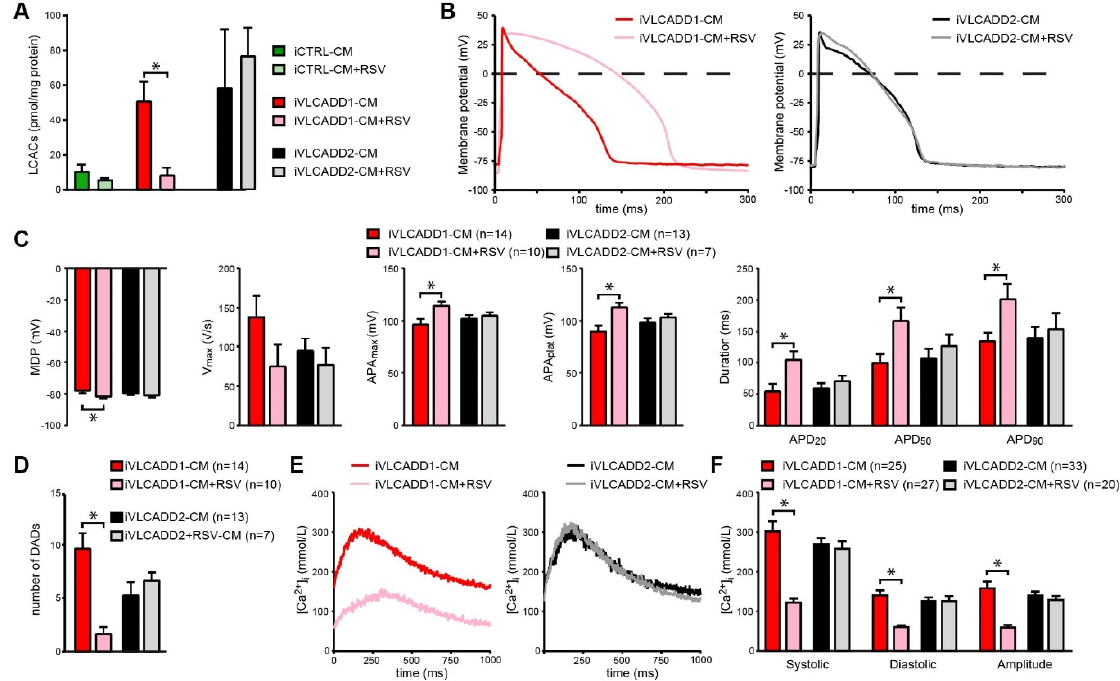
Figure 2. Rescue of electrophysiological abnormalities in iVLCADD1-CMs after pre-incubation with Resveratrol (RSV; 50 µmol/L). A . Intracellular acylcarnitine levels in iVLCADD1-CMs, iVLCADD2-CMs and iCTRL-CMs after RSV incubation for 96 h. Sum of long-chain acylcarnitines (LCACs) (C12-, C14-, C14:1-, C16-, C16:1-, C18-, C18:1-carnitine). Values represent mean + SD in two biological replicates. Statistical analysis was performed using a two-way ANOVA with Tukey’s multiple comparisons test. *= p < 0.05. B . Representative APs paced at 1 Hz. C . Average AP parameters after RSV or vehicle (dimethyl sulfoxide (DMSO)) pre-incubation. D . Number of DADs in absence and presence of RSV. E . Representative Ca 2+ transients of Indo-1 loaded hiPSC-CMs paced at 1 Hz in presence of RSV. F . Average [Ca 2+ ] i after RSV or vehicle (DMSO) pre-incubation. For AP analyses and